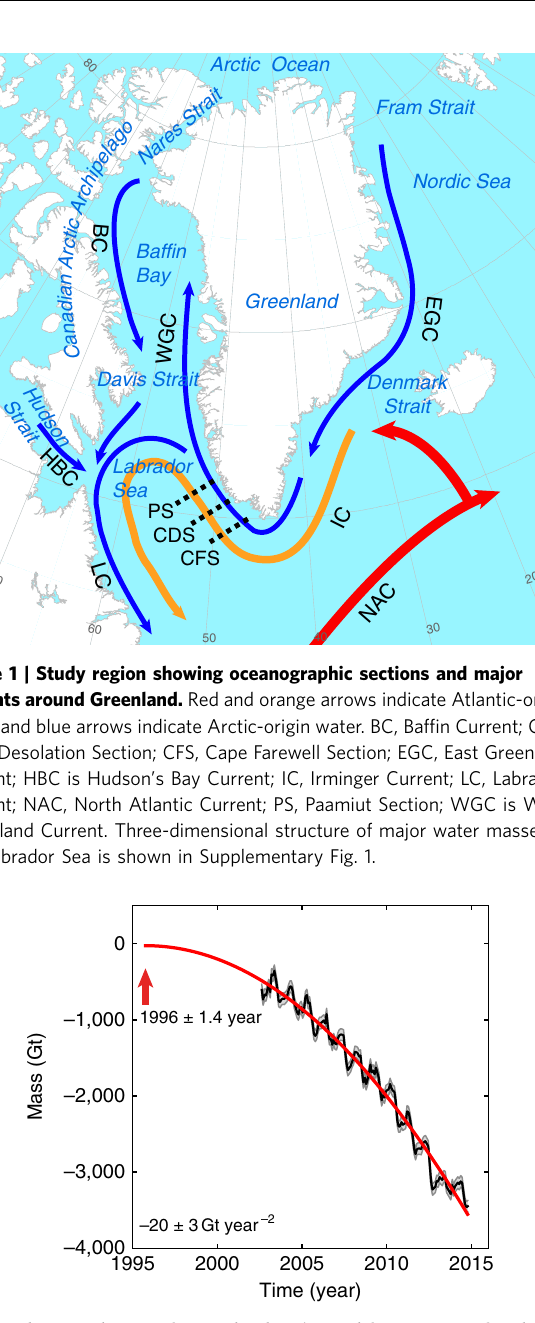
Figure 2 | Mass change of Greenland estimated from GRACE for the period 2002–2014. Black curve shows data, grey shading indicates monthly uncertainty and red curve shows the best fitting constant acceleration model. Onset time of acceleration defined when the rate of mass change is zero, in 1996 (red arrow), with mass arbitrarily set to